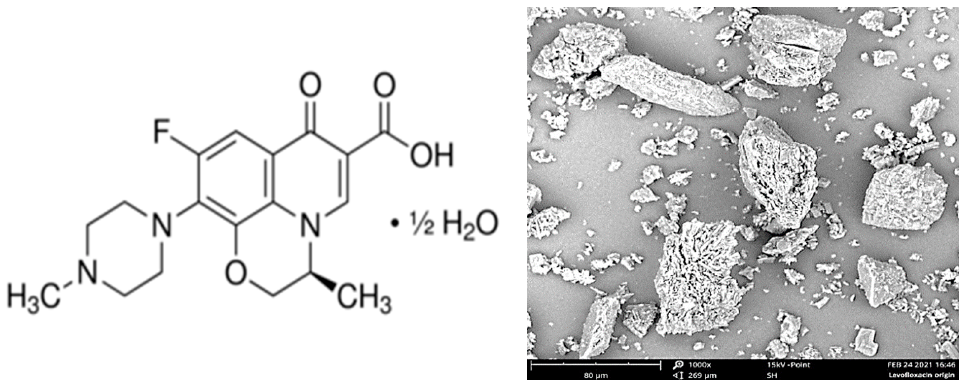
Figure 1. Structural formula of LFX ( left ) and scanning electron microscopy (SEM) image of its initial particles ( right ).